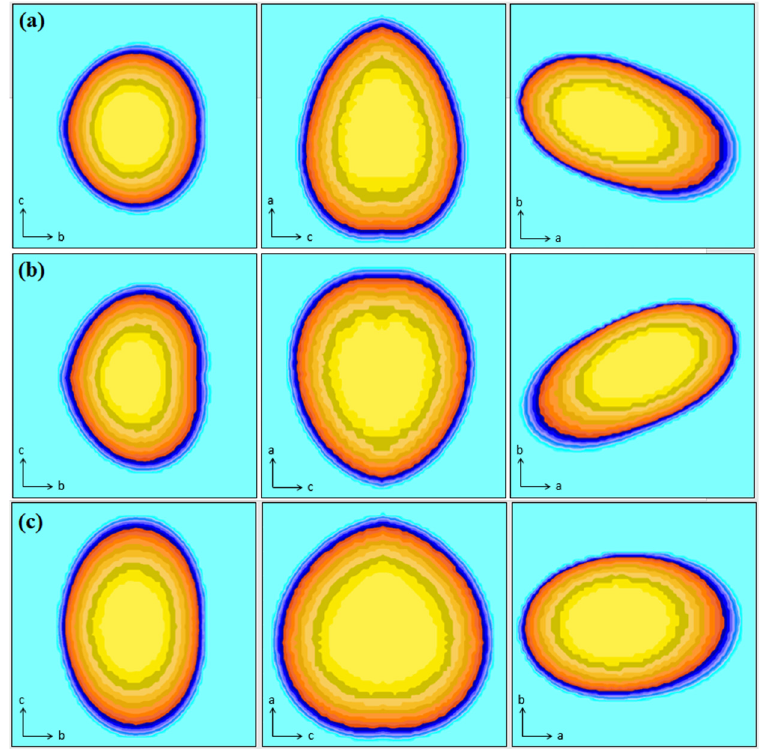
Figure 3. Crystallite shape from the Le Bail refinement of ( a ) ES-POMA, ( b ) TT 100 , and ( c ) TT 200 samples along the directions [100], [010], [001].